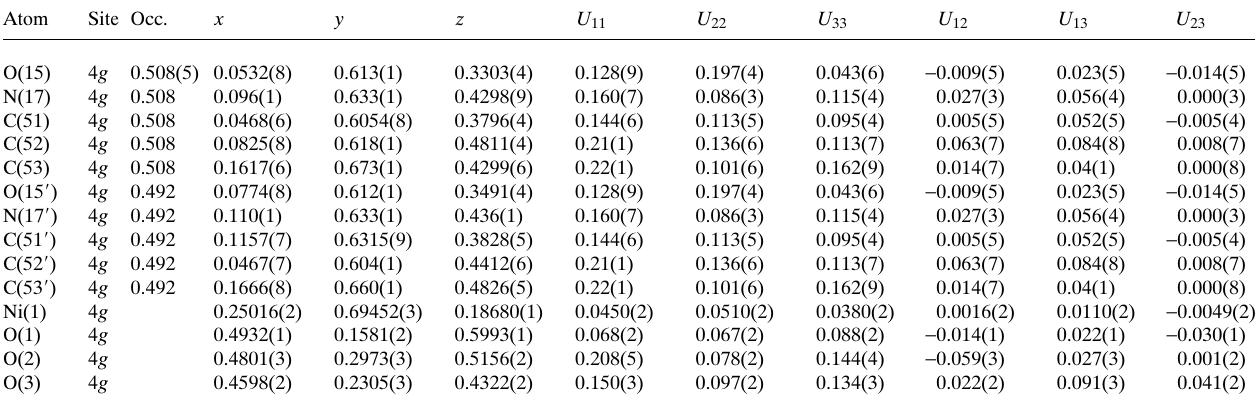
Table 3. Atomic coordinates and displacement parameters (in Å 2 ) .